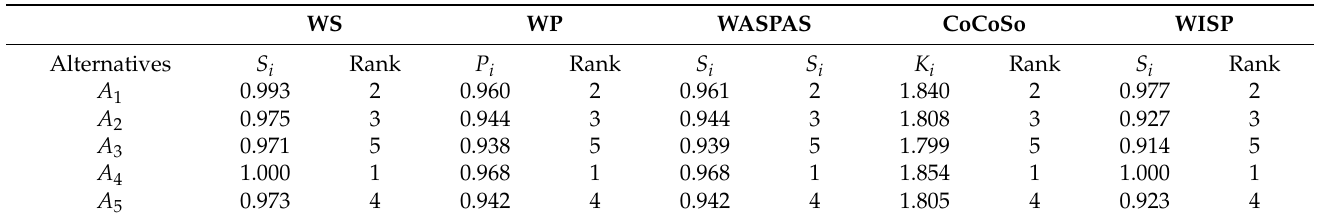
Table 18. Ranking of alternatives on the basis of 150 virtual respondents and crisp methods.